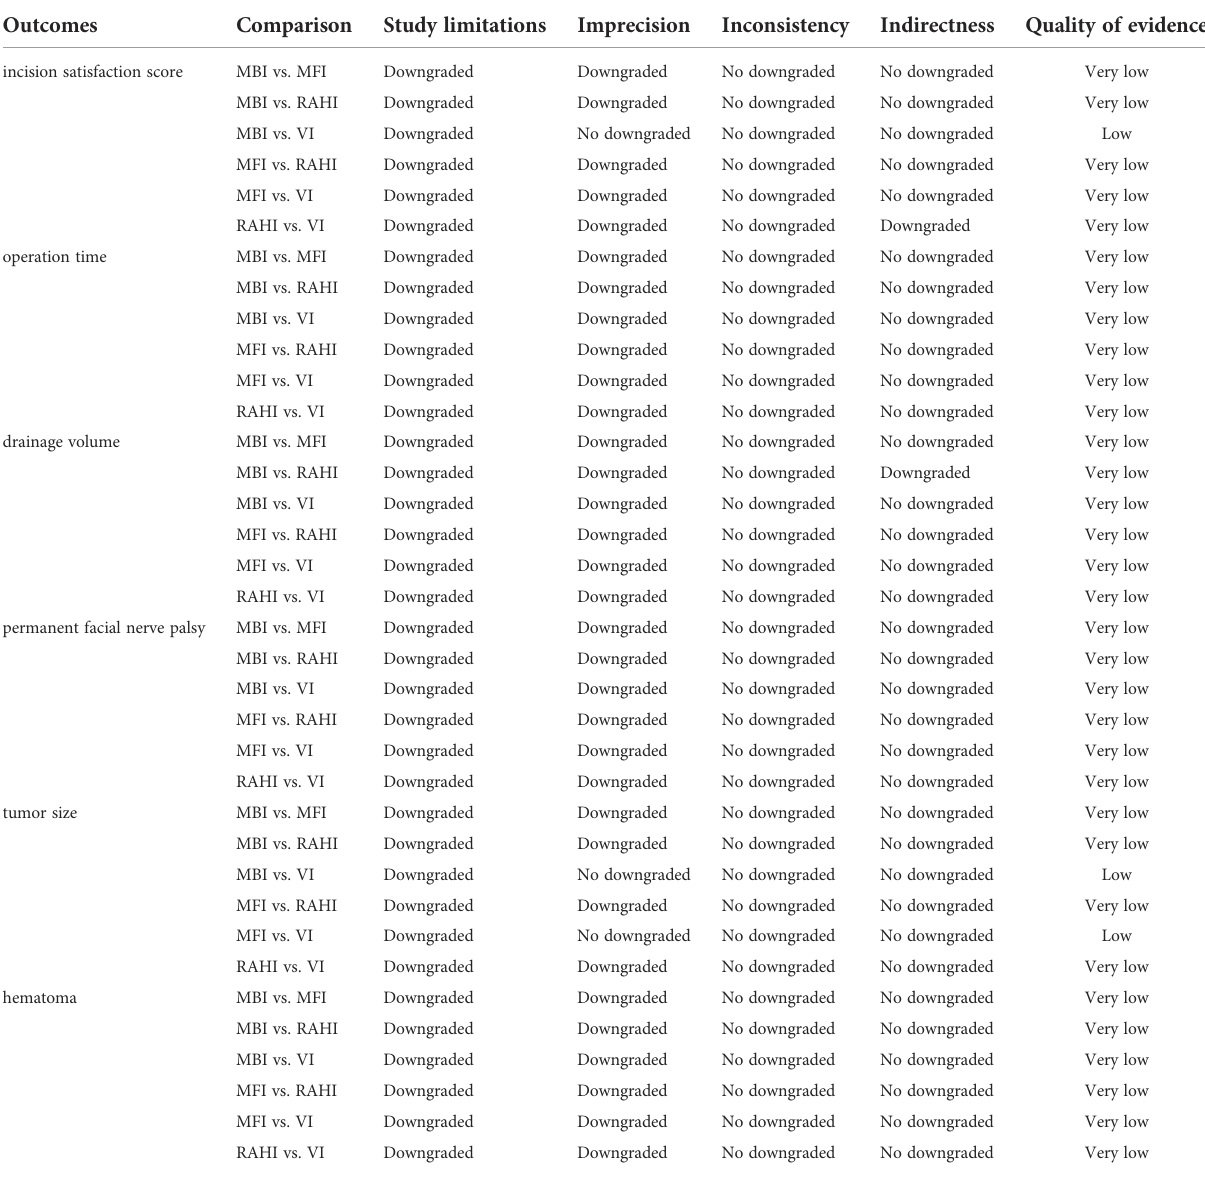
TABLE 7 Quality of evidence for outcomes based on the GRADE